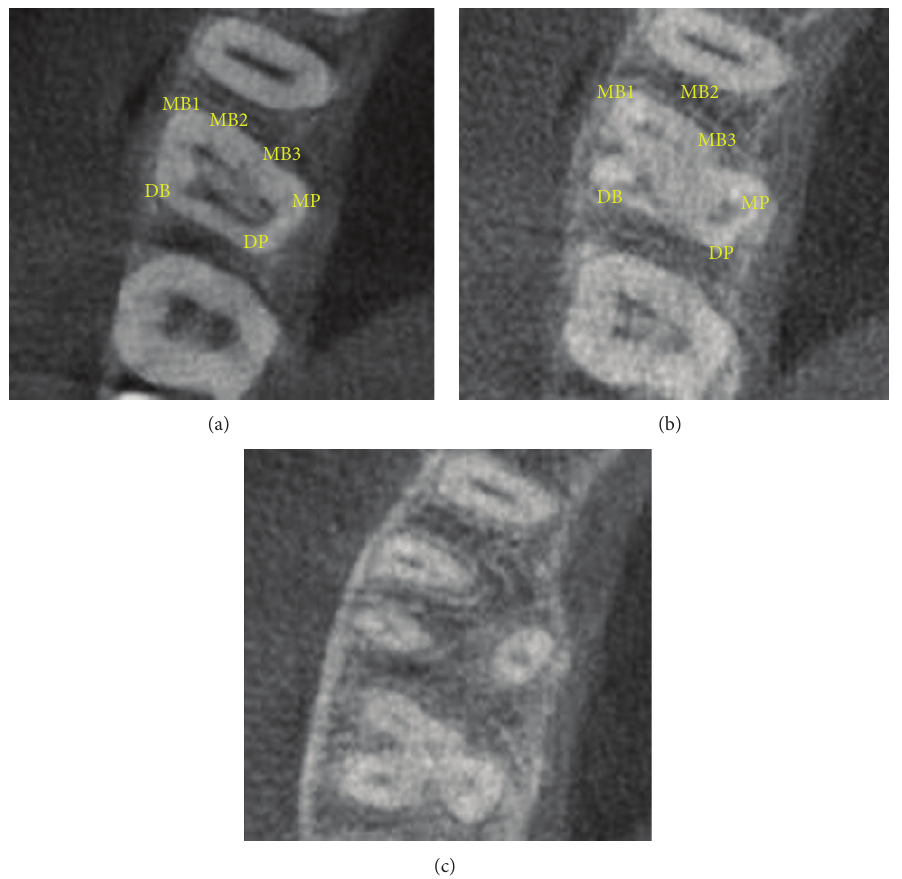
Figure 4: CBCT images showing distinct canal